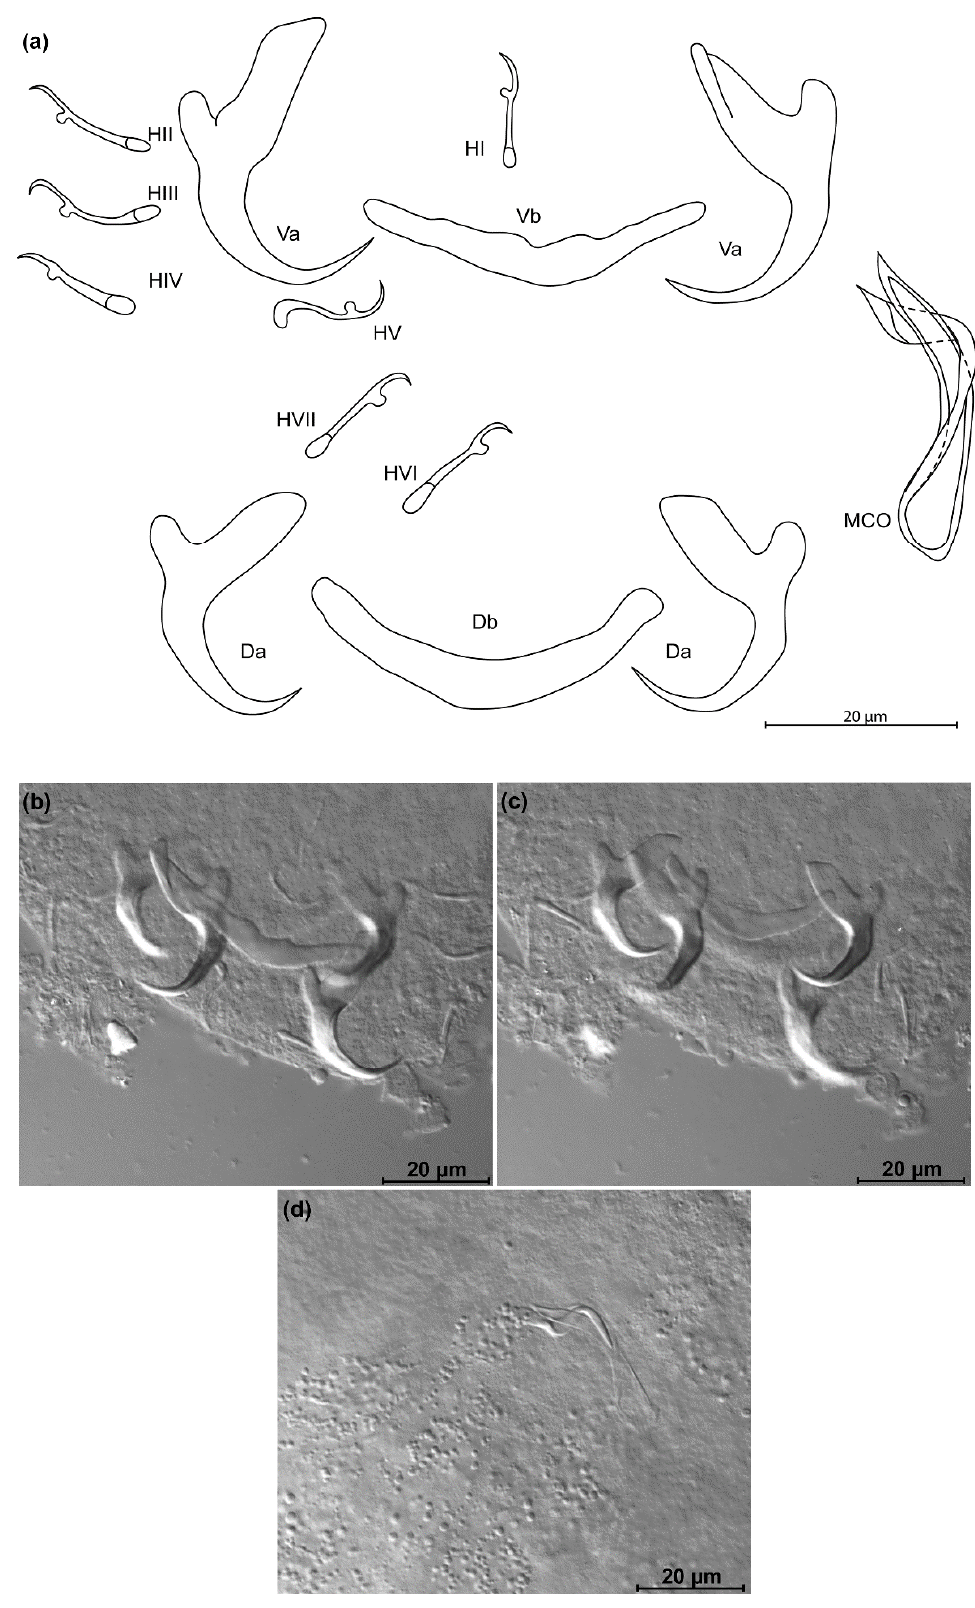
Figure 13. Kapentagyrus chochamandai n. sp. (ex Microthrissa moeruensis ). ( a ) Drawings of sclerotized structures, Va-ventral anchors, Db-dorsal bar, Vb-ventral bar, H-hooks (pairs I to V—ventral; pairs VI, VII—dorsal). ( b ) Micrograph of ventral anchors and ventral bar. ( c ) Micrograph of dorsal anchors and dorsal bar. ( d ) Micrograph of MCO.